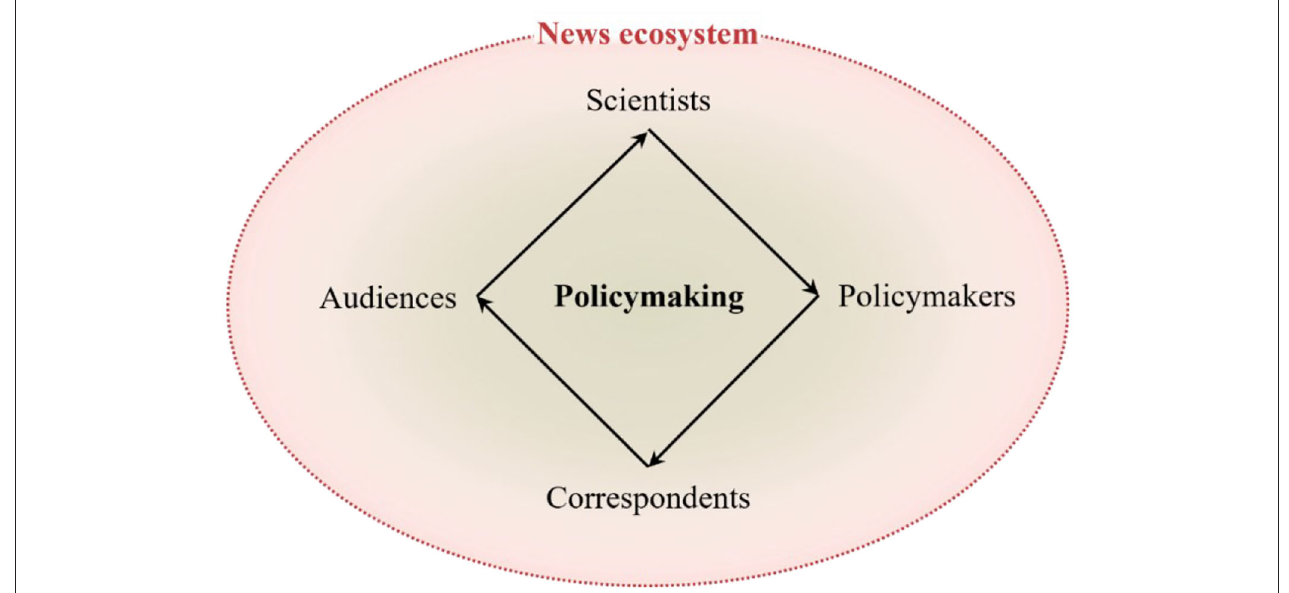
FIGURE 2 | Under the umbrella of the news ecosystem, science-based policymaking is a cyclical process of scientific and societal consensus in which every scientist, policymaker, correspondent, or audience has a stake. Efficacious feedbacks between policy needs and gaps in scientific knowledge can underpin policy outcomes, with stakeholders contributing their